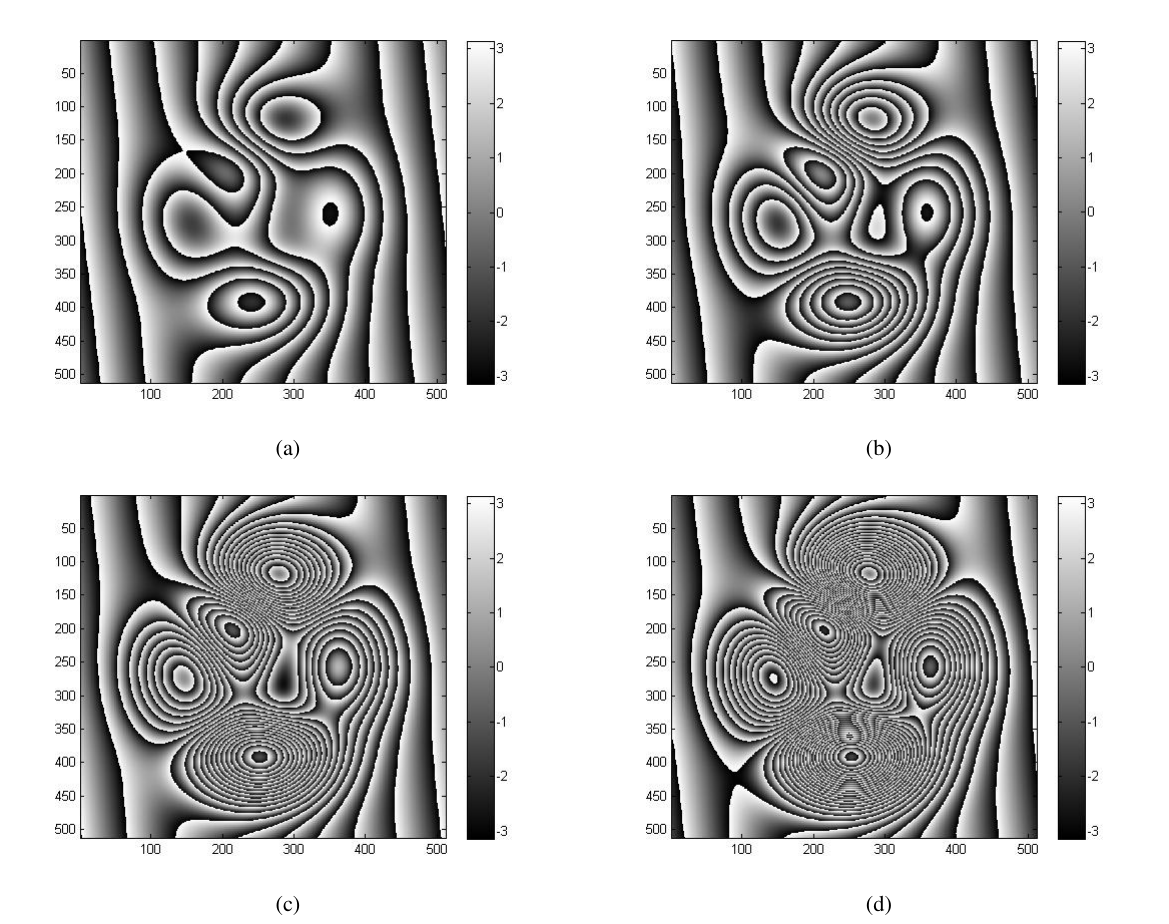
Figure 3: The simulated interferogram with different number of fringes.